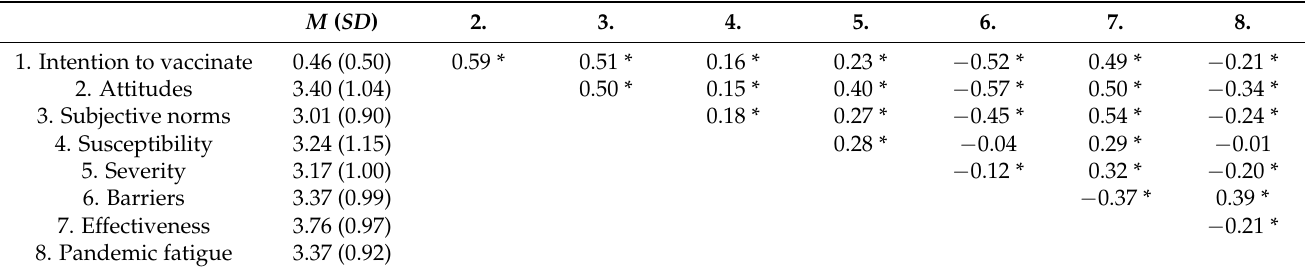
Table 2. Means, standard deviations, and correlations between the intention to vaccinate children and other study variables ( N =